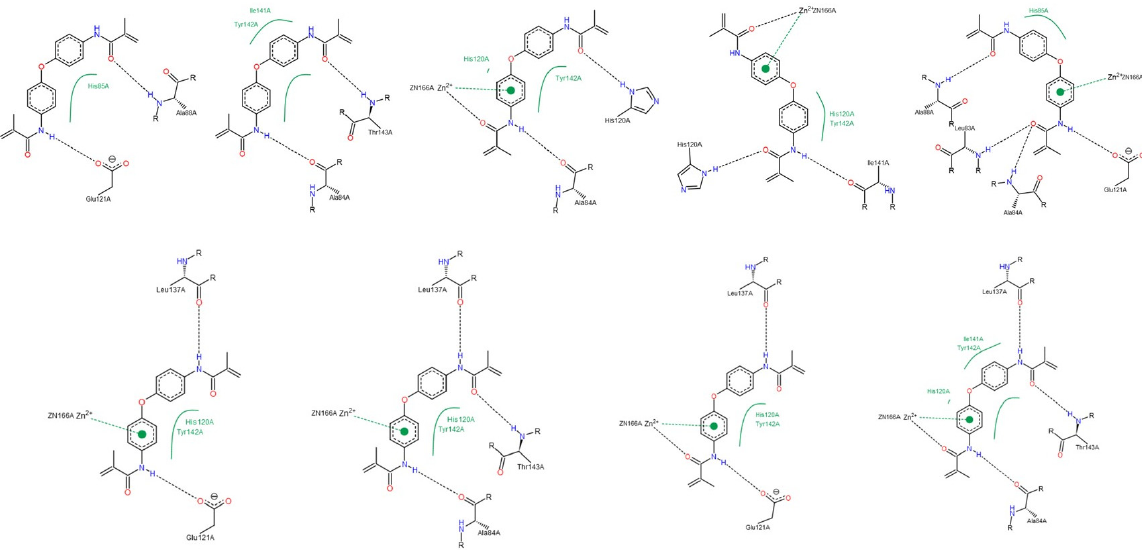
Figure A17. Interactions between compound C and MMP-2, by PoseView calculations.